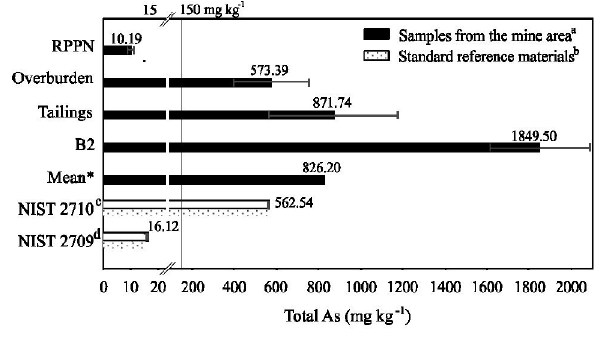
Figure 1. Total arsenic content in samples. -------- and ....... , industrial threshold and soil As prevention level, as established by CONAMA (2009), respectively. *mine refuse. a,b particle size